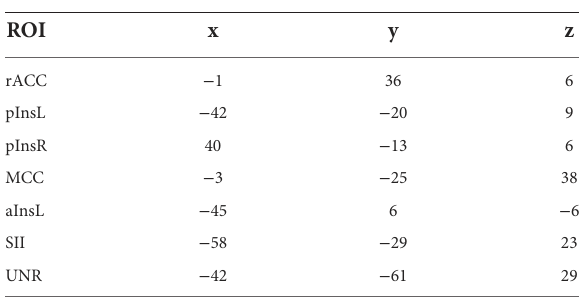
TABLE 1 MNI coordinates of the regions of interest used in the manuscript.